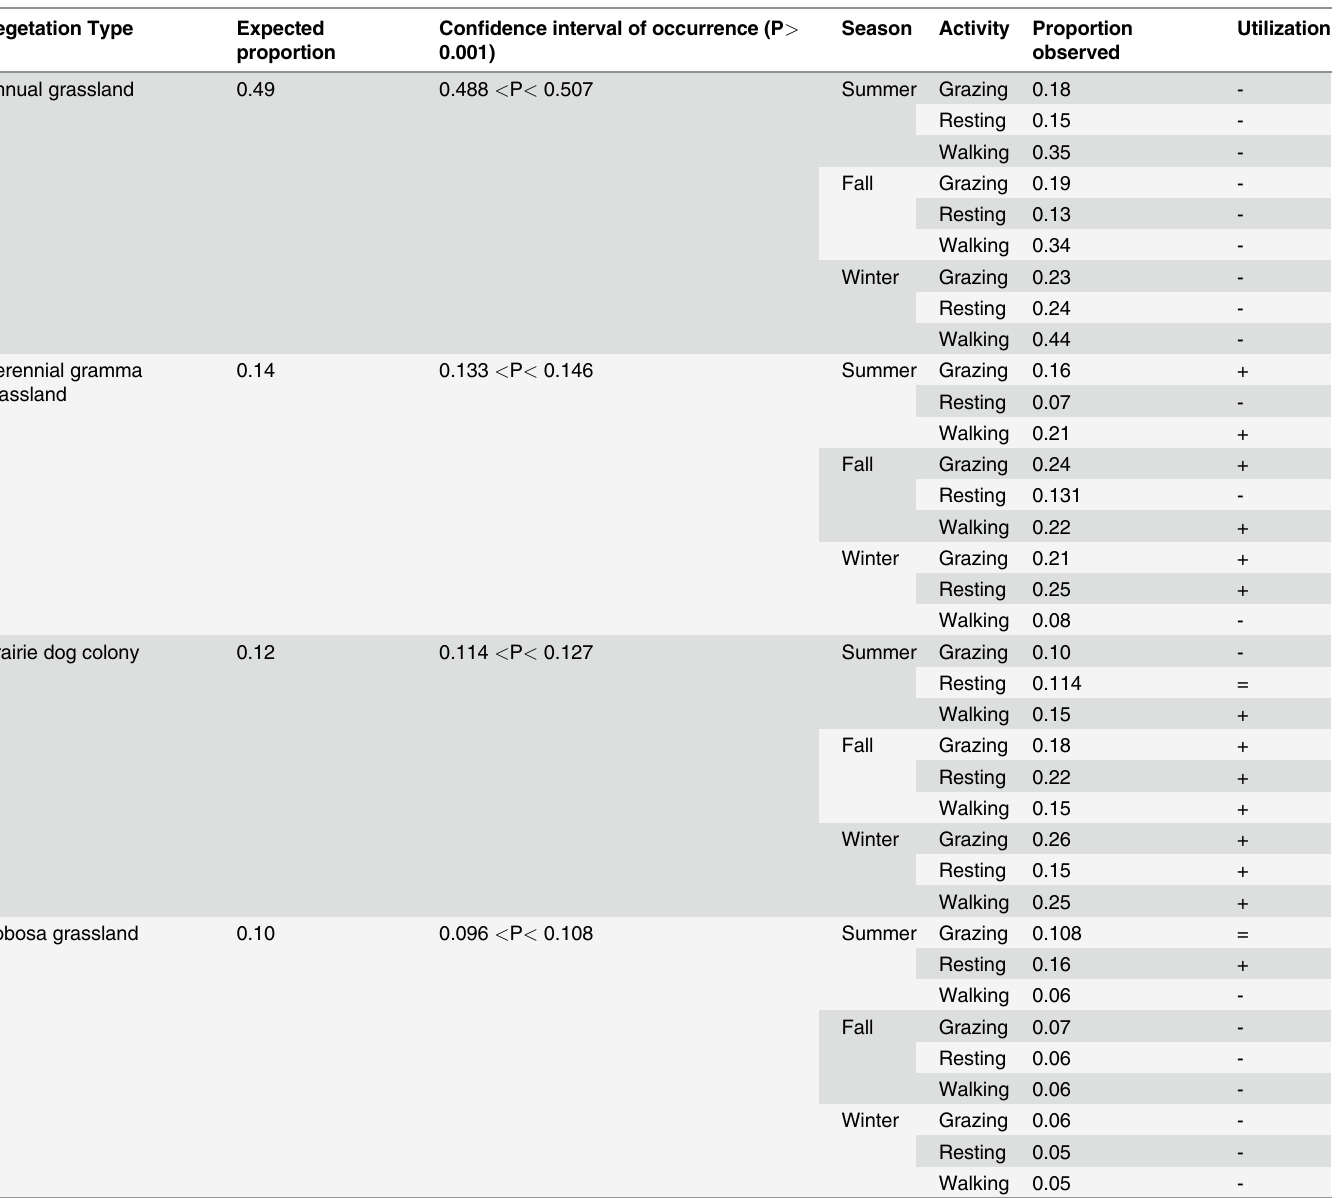
Table 1. Large-scale